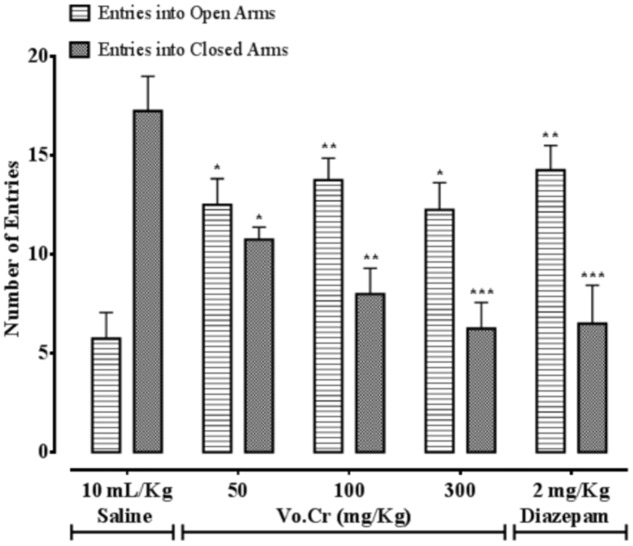
Bar-graph showing effects of Verbena officinalis crude extract (Vo.Cr) and diazepam on numbers of mice entries in open and closed arms in elevated plus maze model. Data expressed as mean ± SEM, n = 4. ∗P < 0.05, ∗∗P < 0.01, ∗∗∗P < 0.001 vs. saline group, one-way ANOVA with post hoc Tukey test.